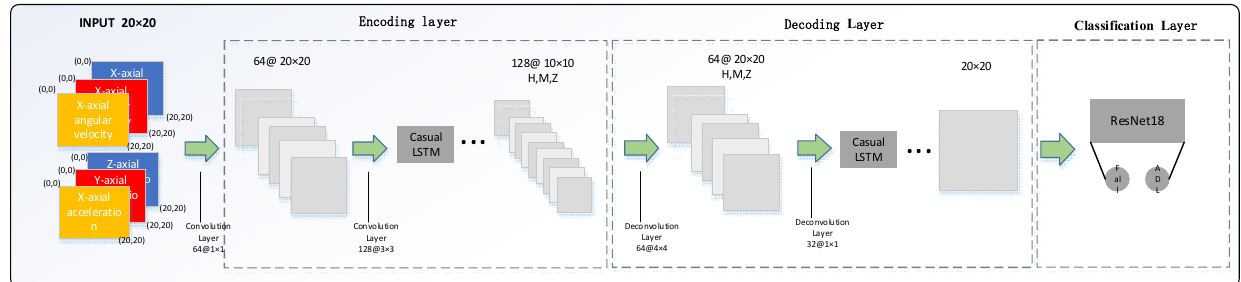
Figure 2. Architecture of neural network implemented for fall detection with classification of the data. Causal LSTM